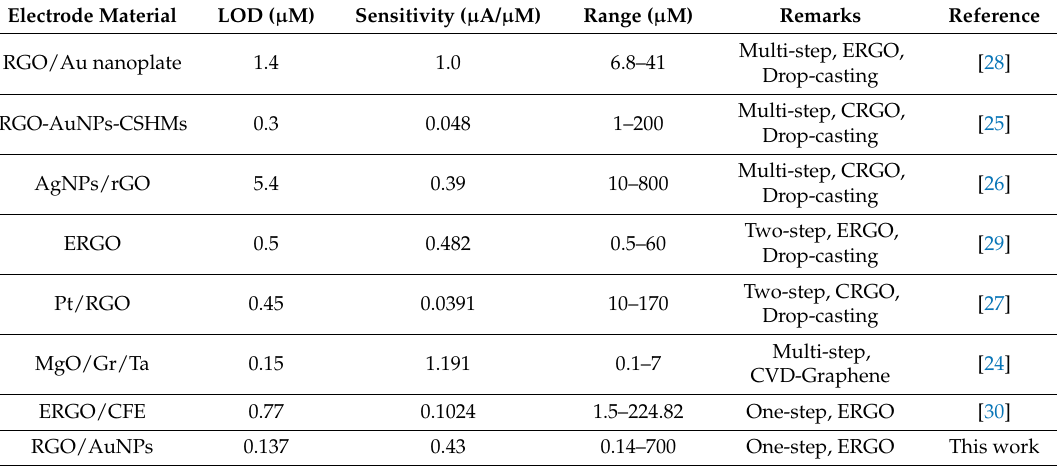
Table 2. Comparison of various graphene-based, composite-modified electrodes towards the detection of dopamine.